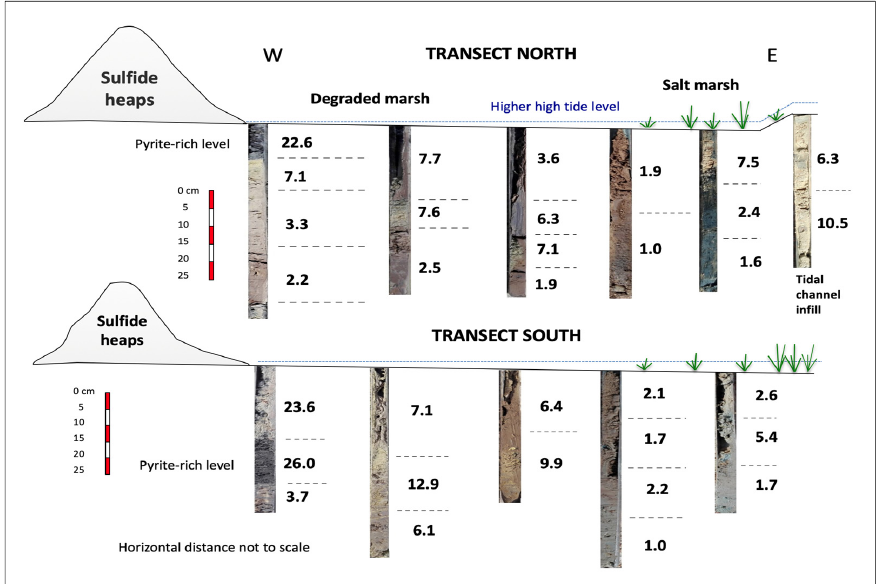
Figure 9. Pollution load index ( PLI ) values of the soil core samples.